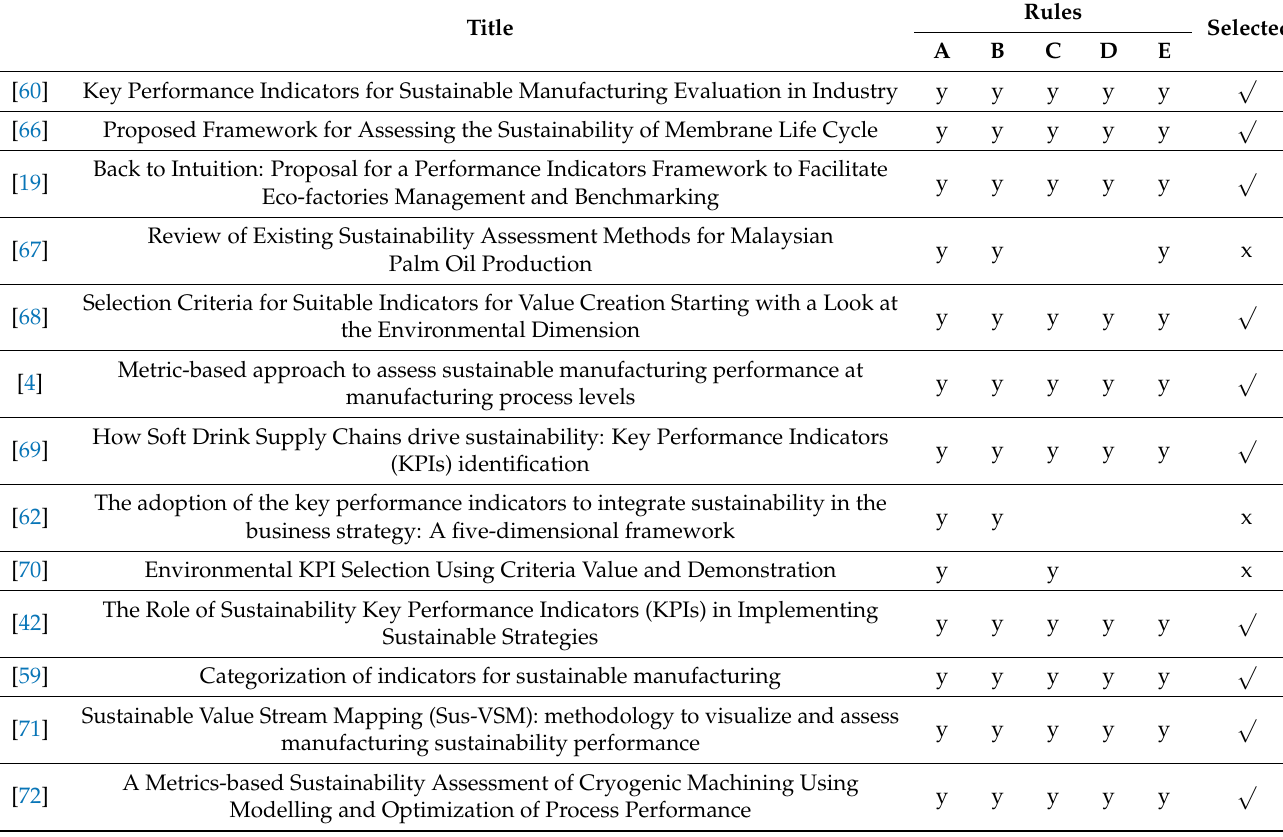
Table 1. Result of analysis of publications presenting sets of sustainability KPIs.